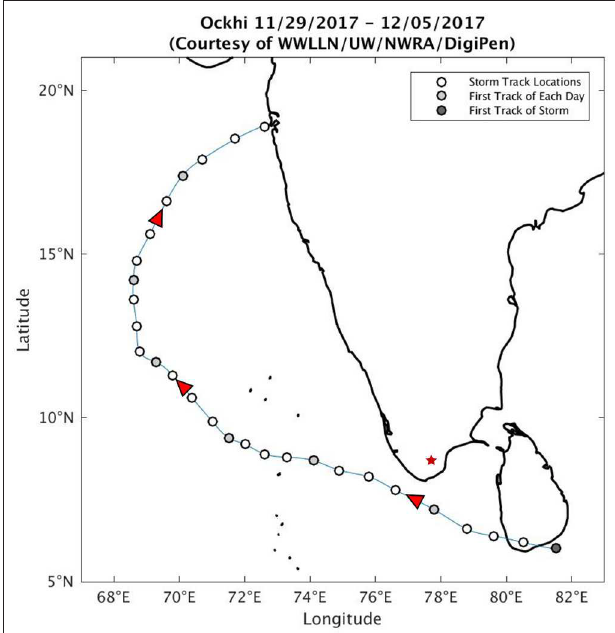
FIGURE 1 | Track map of Ockhi cyclone; the red star indicates the location of the observation site, Tirunelveli; the red arrows show the direction of motion. (Modification of the original image from